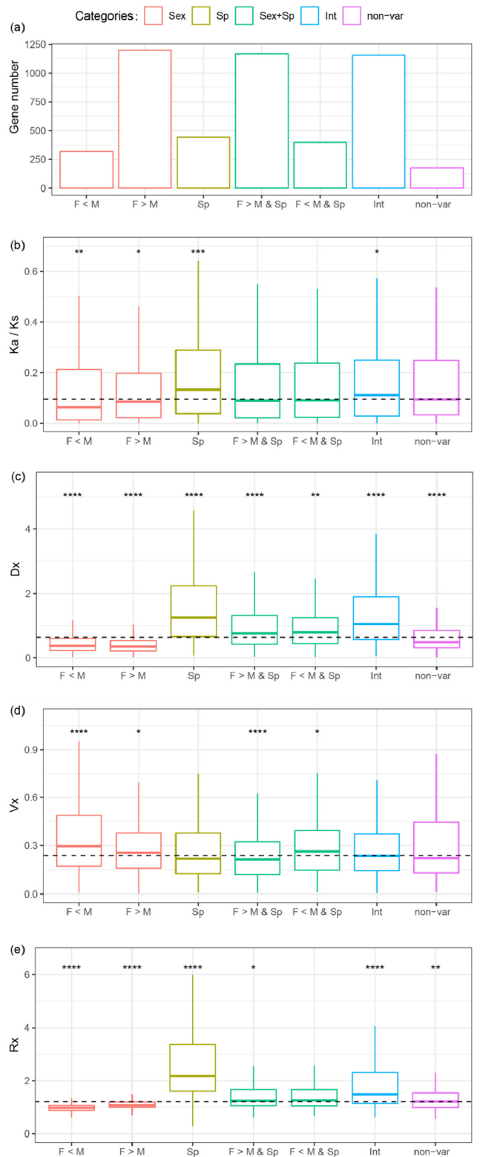
Figure 5. The evolution of protein coding sequences and gene expressions in sex-variable, species-variable, sex- and species-variable, interaction-variable, and non-variables genes. The number of genes ( a ), evolution of protein coding sequences (Ka / Ks ratio) ( b ), gene variations across species (Dx) ( c ), gene variations within Middle East Asia Minor 1 (MEAM1) (Vx) ( d ), and evolution of gene expression (Rx) ( e ) in each of the gene categories. Sex = sex-variable genes; Sp = species-variable genes; Sex + Sp = sex- and species-variable genes; Int = interaction-variable genes; non-var = non-variable genes; F = female-biased; M = male-biased. The dash line in the diagram ( b ), ( c ), ( d ), or ( e ) indicates the median of all values. Significant differences were determined using the Mann–Whitney U tests through the comparisons between each gene category and the median levels: * p < 0.05, ** p < 0.01, *** p < 0.001, **** p < 0.0001.